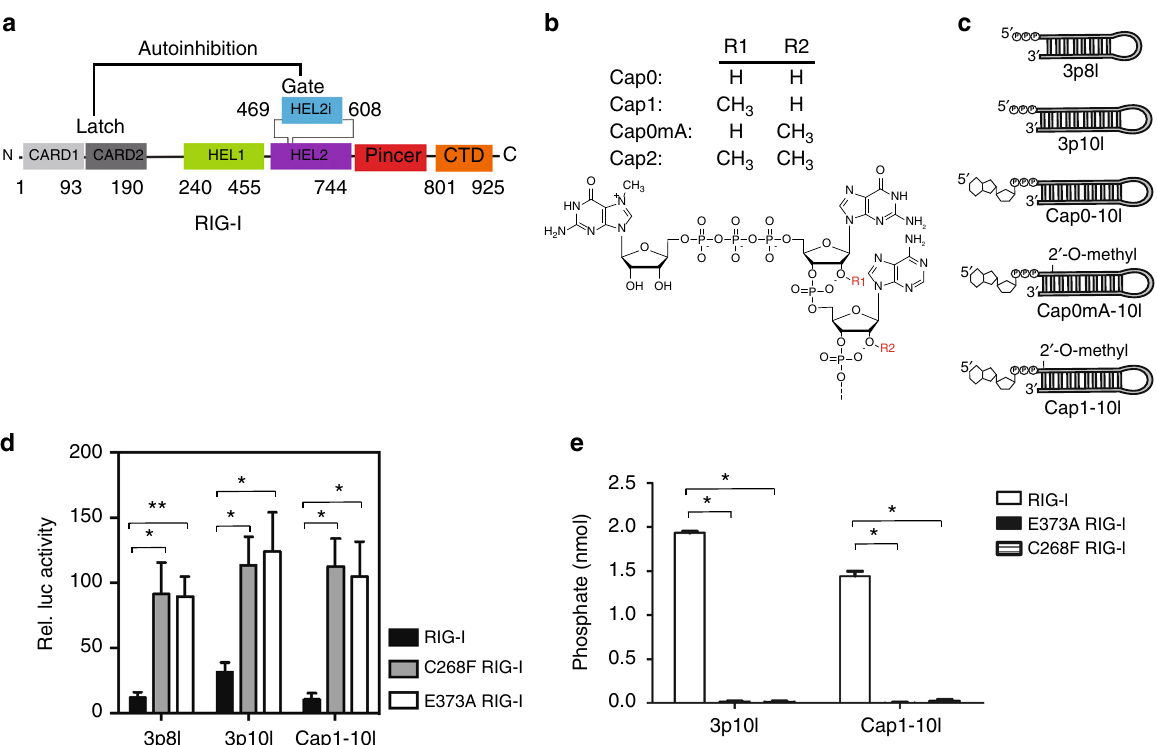
Fig. 1 RNA chemical structures and IFN- β activity. a Domain arrangement of RIG-I (1 – 925). Autoinhibition is shown between CARD2 latch region and HEL2i gate motif. b The chemical structures of an m7G cap and 2 ′ -O-methylation modi fi cation at N 1 or N 2 position are presented. Important features for Cap0, Cap1, Cap0mA, and Cap2 are highlighted. c Schematic representations of studied 8- and 10-mer hairpin RNAs that bear different modi fi cations at the 5 ′ RNA terminus. 3p10l and Cap1-10l represent the molecular signature of viral and self-RNA, respectively. d The IFN- β luciferase signal is plotted as recorded in WT/SMS RIG-I dual reporter assays stimulated with indicated RNAs. Basal IFN- β activity of WT RIG-I in the absence of RNA transfection was subtracted. The signi fi cance of differences between groups was evaluated by unpaired Student ’ s t test (* p < 0.05; ** p < 0.01). e ATPase activities of Cap1- 10l- and 3p10l-bound WT/SMS RIG-I. The signi fi cance of differences between groups was evaluated by unpaired Student ’ s t test (* p <